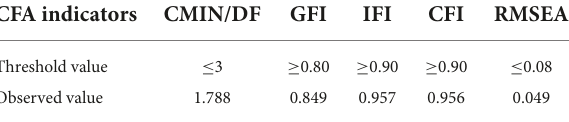
H7: Institutional pressure has a moderating impact on the relationship between green purchasing and the sustainability performance of the manufacturing industry in